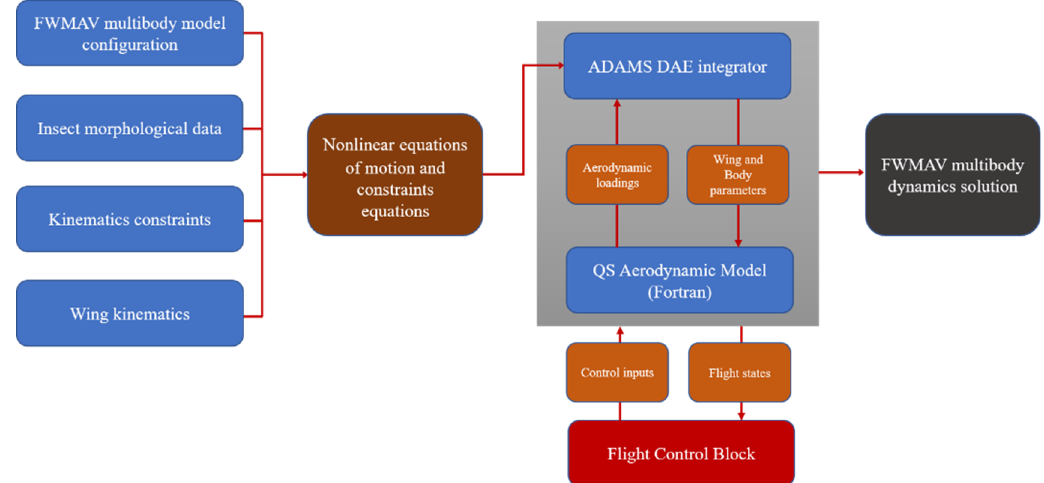
Figure 8. Multibody dynamics simulation framework appended with flight control block.